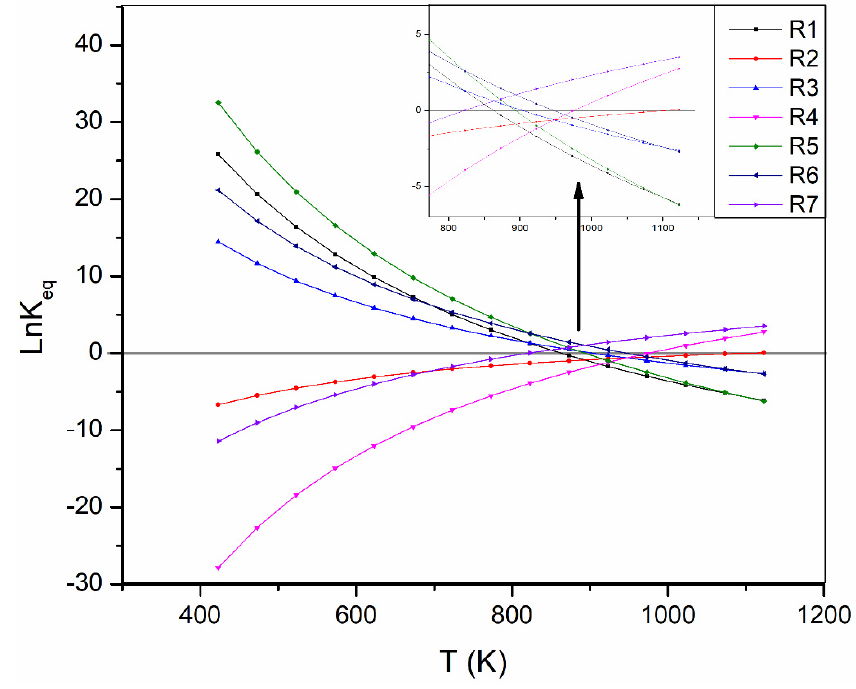
Figure 2. LnK eq versus T plot for R1–R8. (P = 1 atm, H 2 /CO 2 ratio =